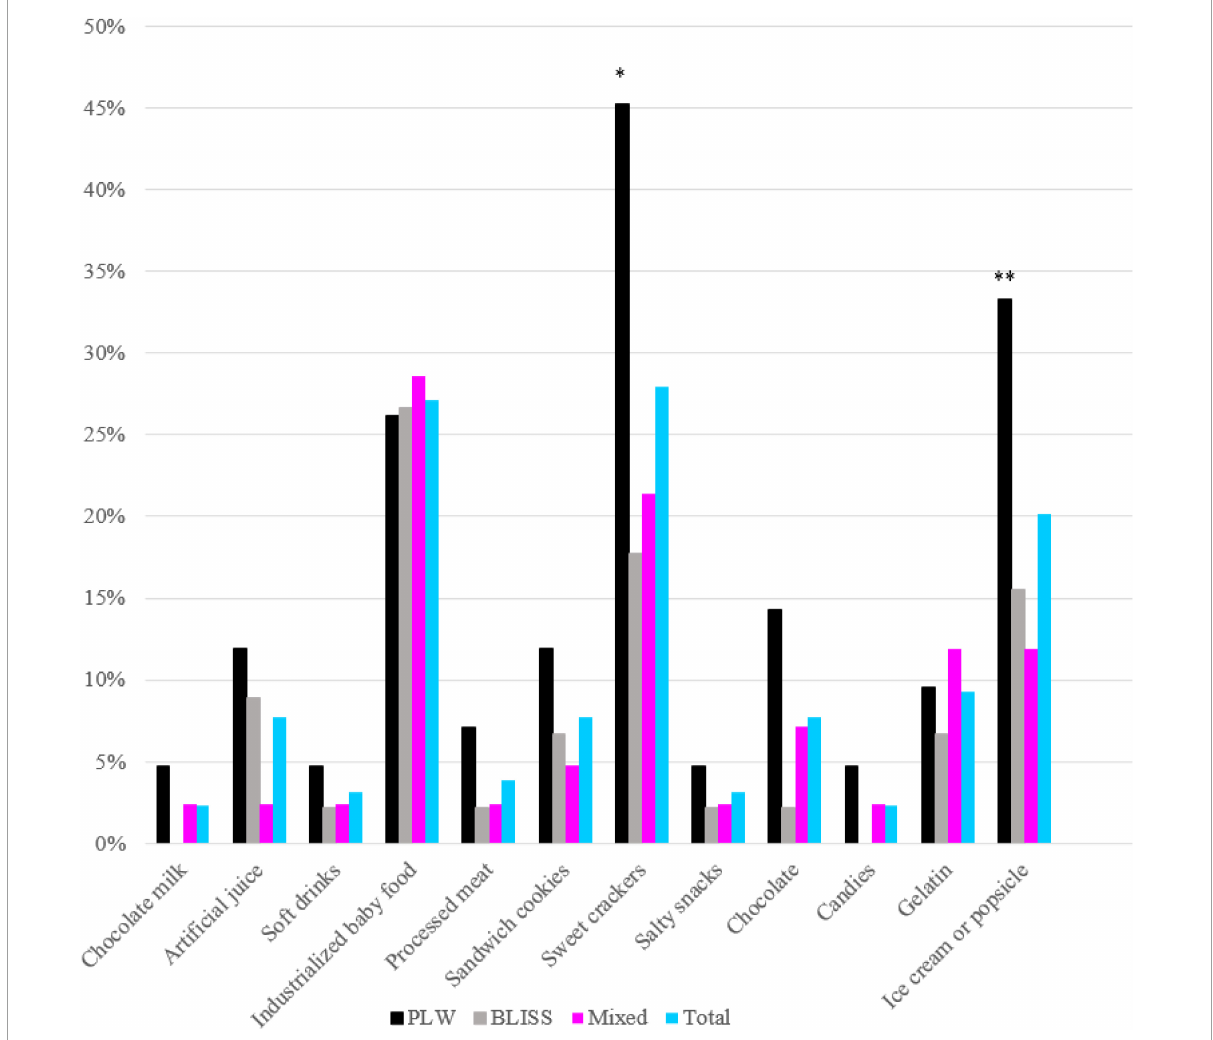
FIGURE2 Prevalence of ultra-processed food offered in the first year of life according to interventions: PLW, BLISS, and mixed groups, Brazil, 2019–2021. PLW, parent-led weaning; BLISS, baby-led introduction to solids. ∗ p < 0.05; ∗∗ p <